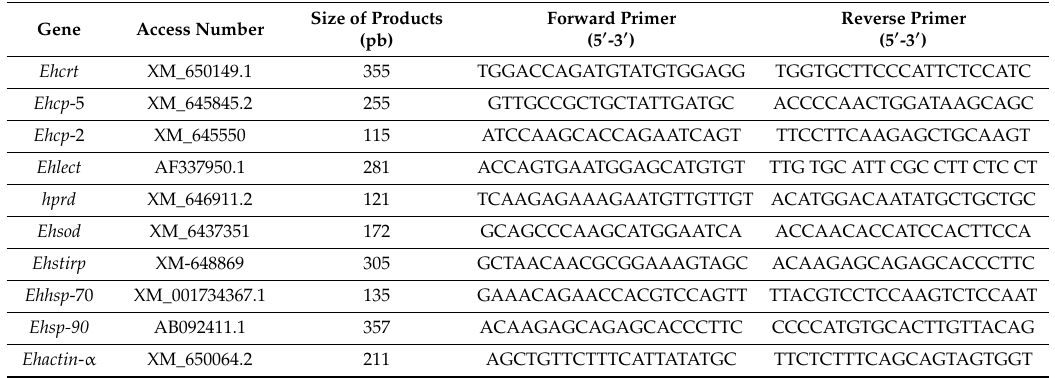
Table 1. Oligonucleotides used in the RT-qPCR assay.